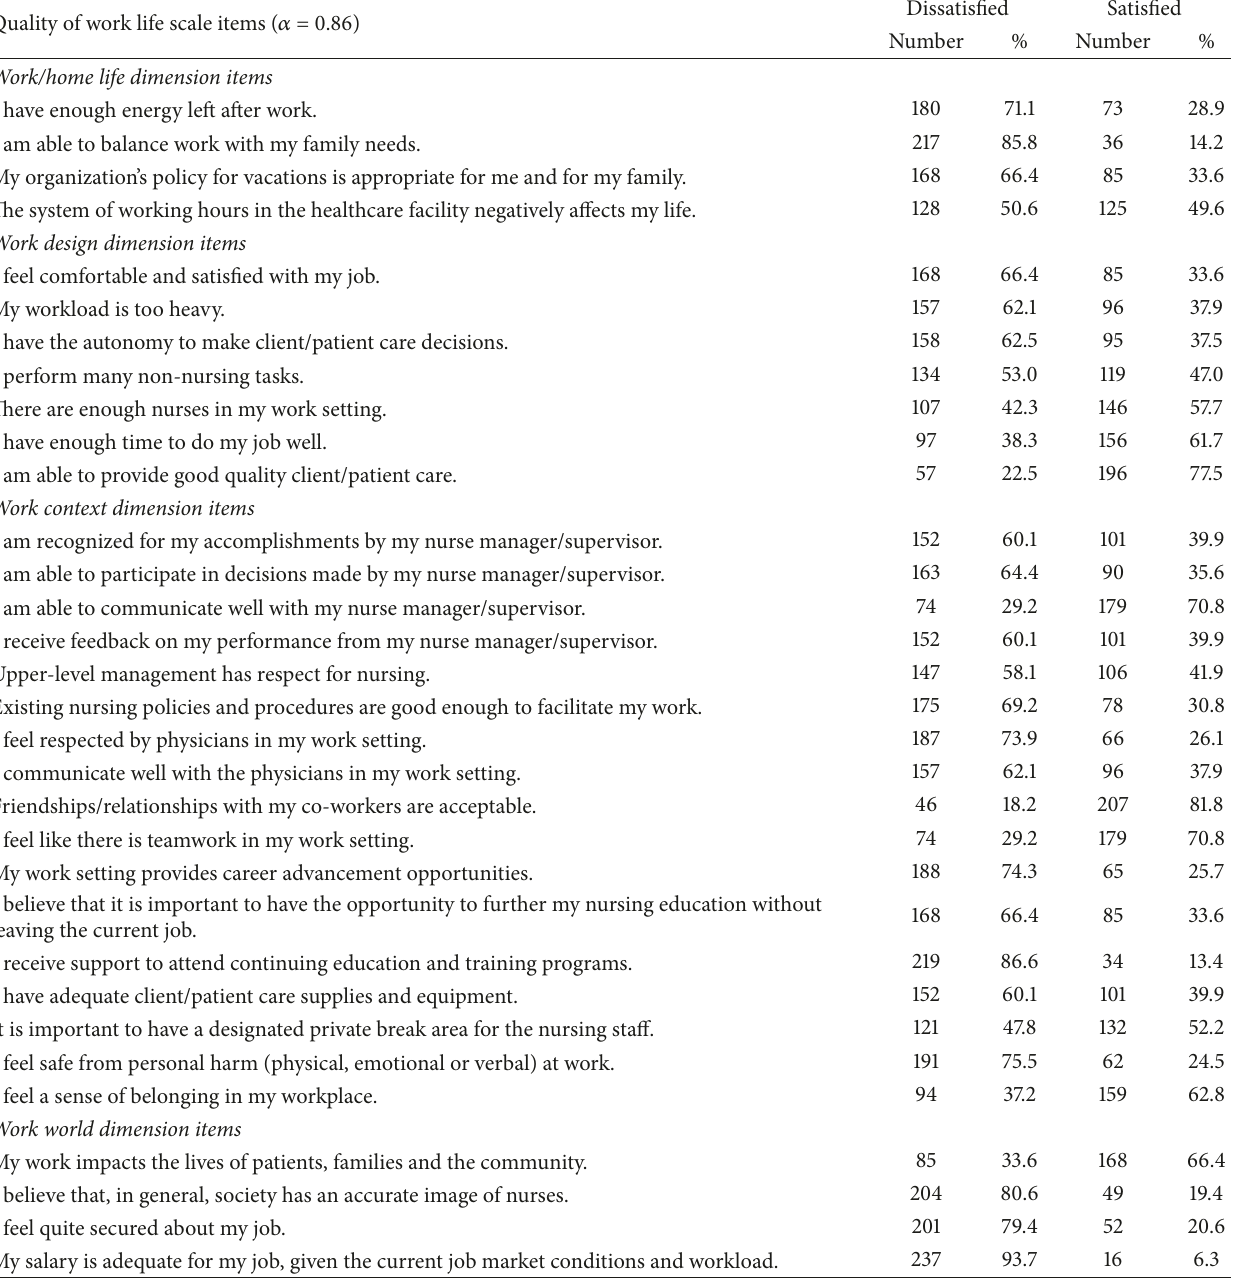
Table 2: Description of the quality of work life scale items among nurses working in Hawassa town public health facilities, March 10–27, 2016 ( 𝑛 = 253